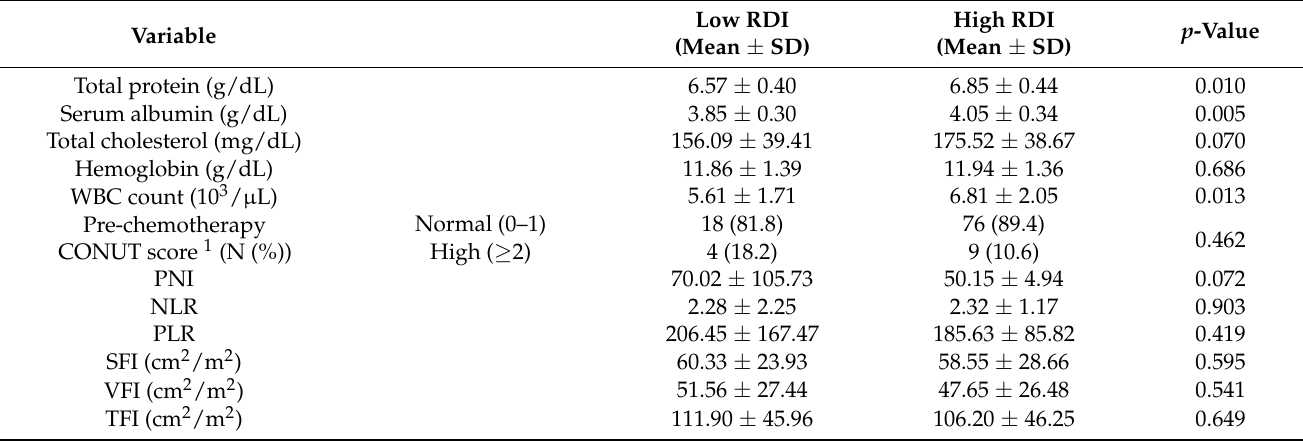
Table 2. Comparison of nutrition, inflammatory index, and body composition according to RDI.